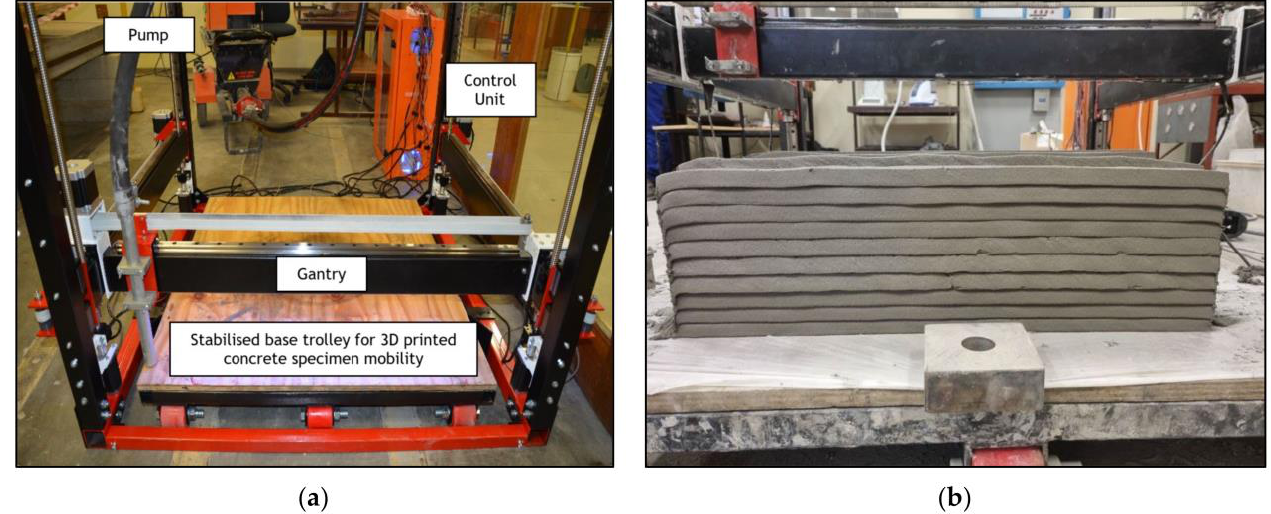
Figure 1. ( a ) Three-dimensional concrete printer coupled with a batch mix rotor-stator pump, as used in this research; ( b ) two double-skin free-standing 3D printed wall elements from which specimens were extracted for testing.